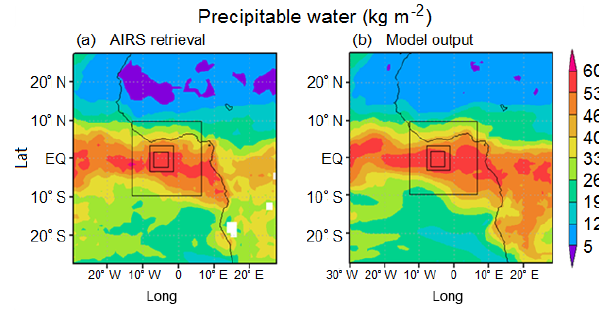
Figure 1. (a) AIRS total precipitable water averaged 7– 9 March 2004, boxes denoting location of the three nested do- mains. (b) Domain 1 model output precipitable water averaged 7– 9 March